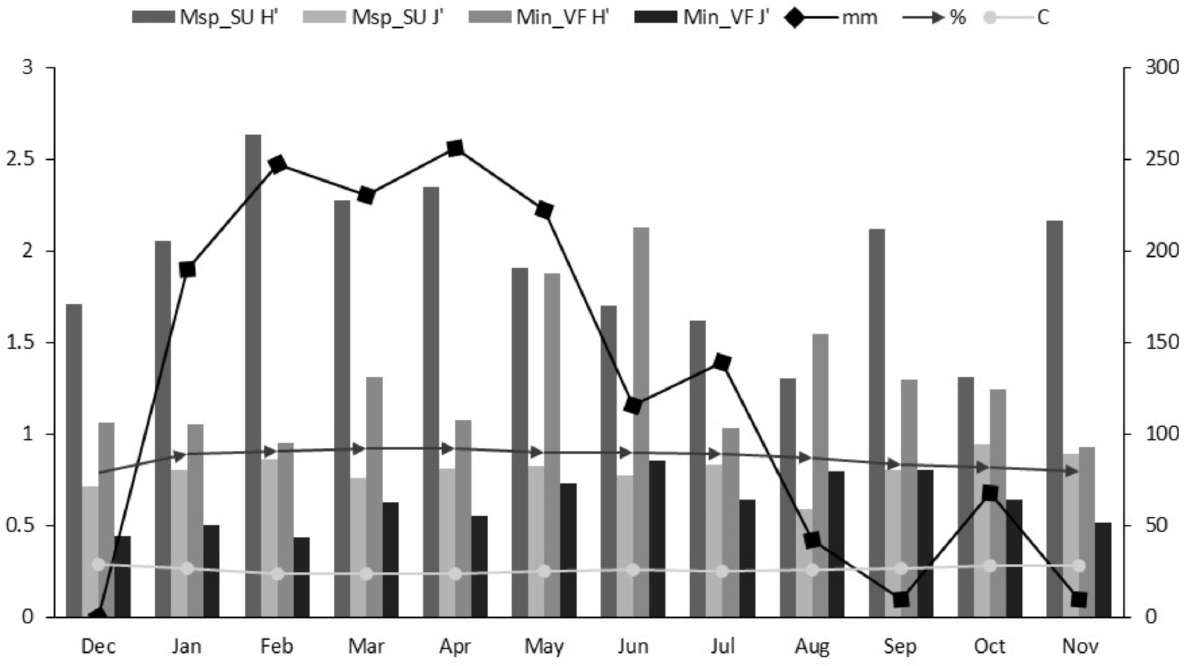
Fig 3 . Diversity (H’) and uniformity (J’) records for pollen types found in samples of honey from Melipona seminigra pernigra (Msp) and Melipona interrupta (Min), as well as temperature (°C), relative humidity (%), and precipitation (mm) data for the communities of Suruacá (SU) and Vila Franca (VF), Resex Tapajós-Arapiuns, Pará, Brazil, between December 2016 and November